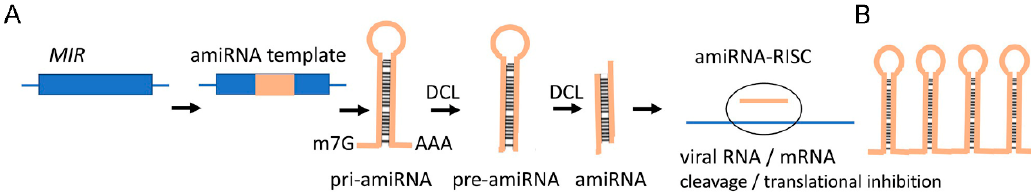
Figure 2. The antiviral amiRNA pathway. ( A ) amiRNA silencing constructs can be generated by replacing known miRNA sequences in a MIR gene with a sequence designed to target and degrade virus RNAs or host mRNAs that encode proteins conferring virus susceptibility. In transgenic plants, the amiRNA construct is transcribed by Pol II into pri-amiRNA which is sequentially processed through pre-amiRNA into amiRNA. Pri-amiRNA or pre-amiRNAs can be potentially applied exogenously and processed into amiRNA inside the cell using cellular RNAi machinery. Mature amiRNAs are incorporated into the RISC to direct the cleavage of target RNA to mediate silencing. ( B ) Multiple amiRNAs may also be easily expressed from a single precursor as tandem repeats which can target multiple sites of the same virus or several viruses.